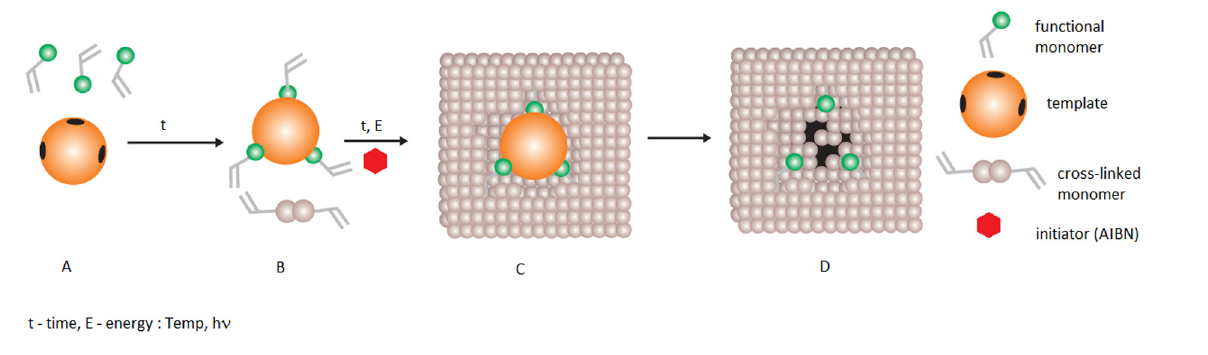
Figure 2: A scheme for molecularly imprinted polymer preparation, wherein A - formation of a pre-polymerization complex; B - addition of a cross linking monomer and initiator; C - polymerization reaction; D – removal of the